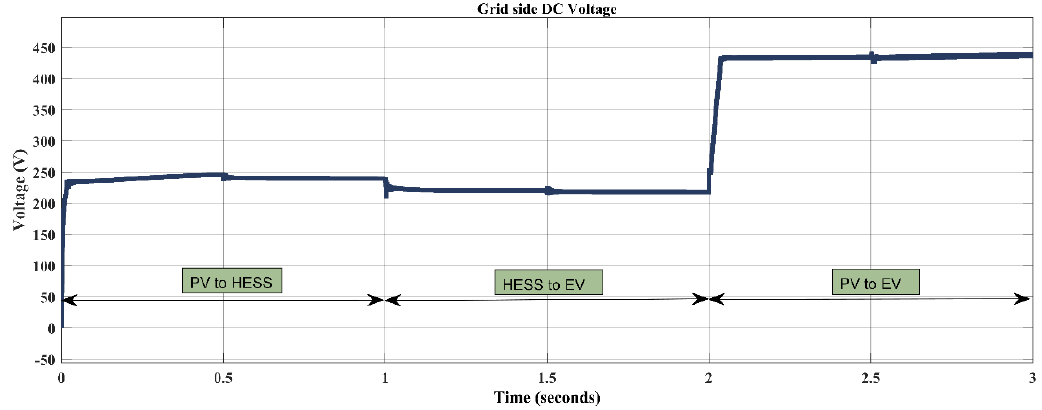
Figure 24. Grid DC Voltage for various modes of operation. The below Table 3 represents the comparison of the proposed Multiport with its counterpart MPPT Algorithms and in table 4 we mentioned the PV Module and HESS parameters. Figure 25 represents the Efficiency comparison of different MPPT with con- verter models. Table 3. Detailed comparison of the proposed Multiport with its counterpart MPPT Algorithms.